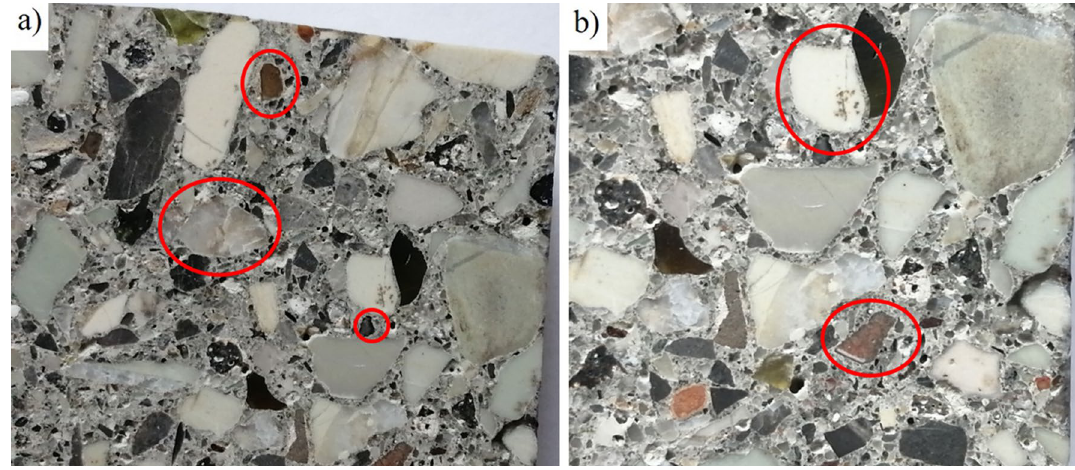
Fig. 5 Macroscopic characterization of the samples collected: a clasts of different size; b clasts of different